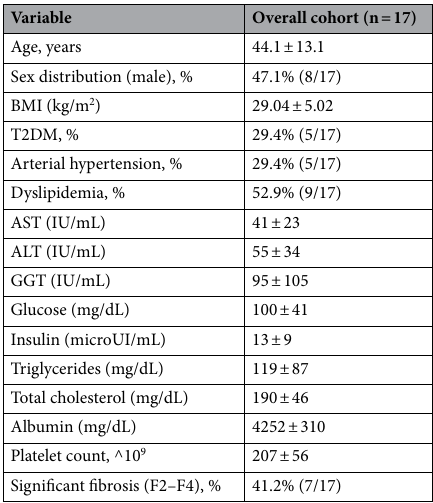
Table 1. Clinical and analytical characteristics of the study cohort employed for immunohistochemistry and gene expression analyses. BMI body mass index, T2DM type 2 diabetes mellitus, AST aspartate